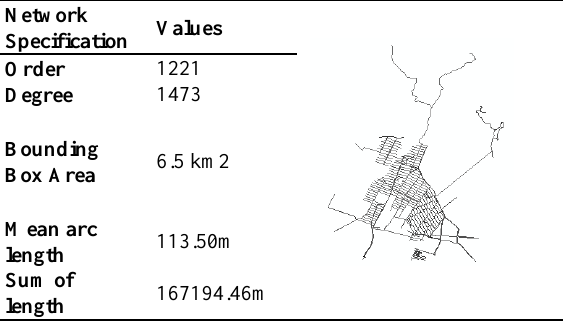
Table 1. The specifications of the experimental network.